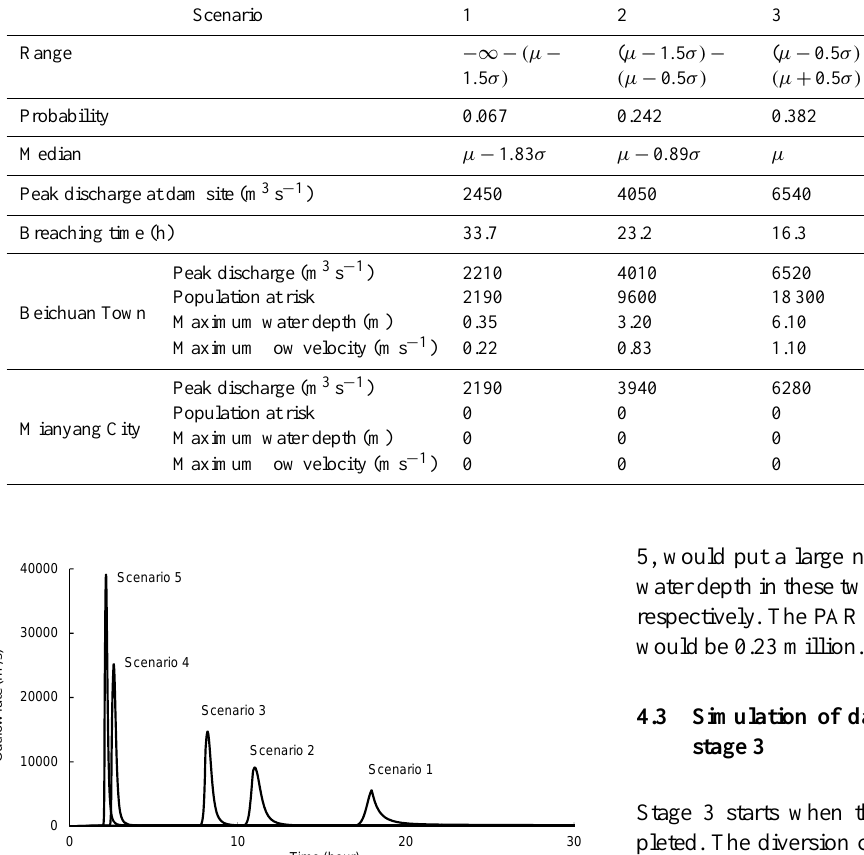
Table 7. Dam-break floods in Beichuan Town and Mianyang City in stage 3. Scenario